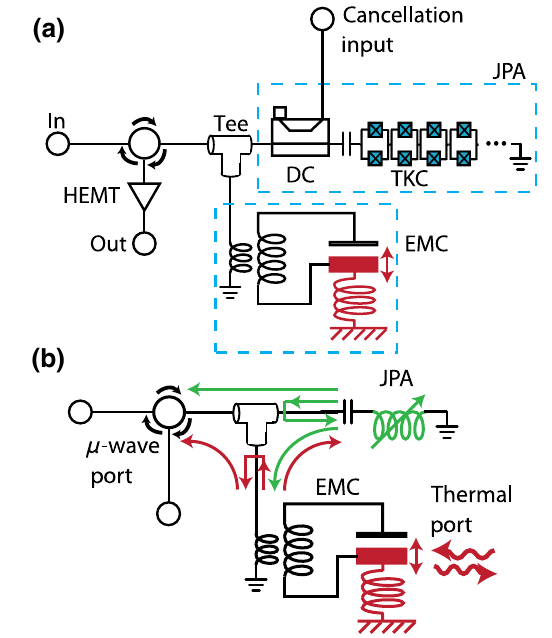
FIG. 1. (a) An experimental schematic of the coherent feedback network. A microwave tee connects an EMC to a JPA—here broken down into its directional coupler (DC) and TKC subcomponents—and provides an overall input-output port. The input port is typically driven by a strong electro- mechanical coupling tone, but this tone is typically cancelled at the DC, preventing its strong carrier from driving the TKC nonlinear. Microwave signals are detected at the output port. (b) Conceptual schematic of coherent interconnections. Ideally, the JPA acts as an overcoupled and wideband linear resonator with a tunable center